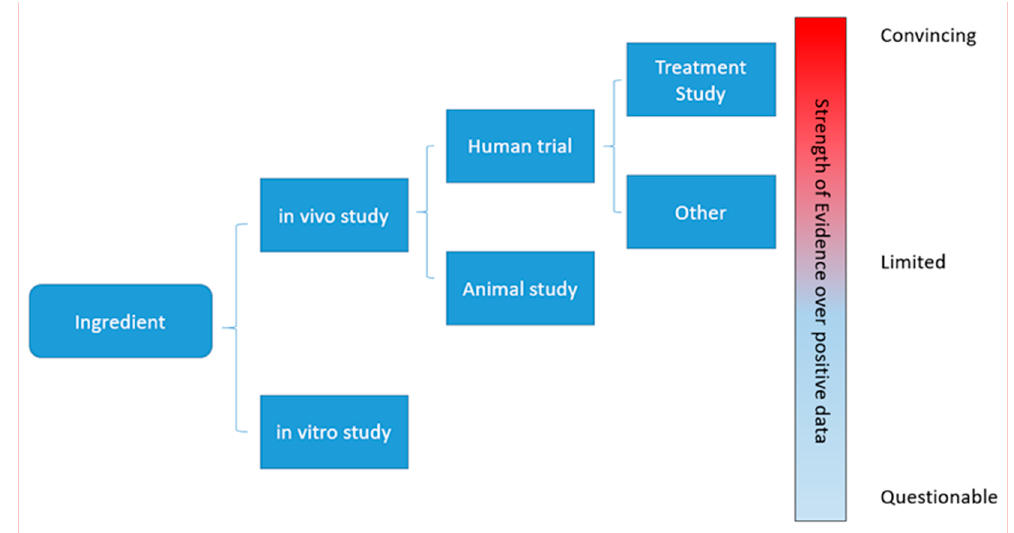
Figure 1. Strength of evidence levels for evaluation.